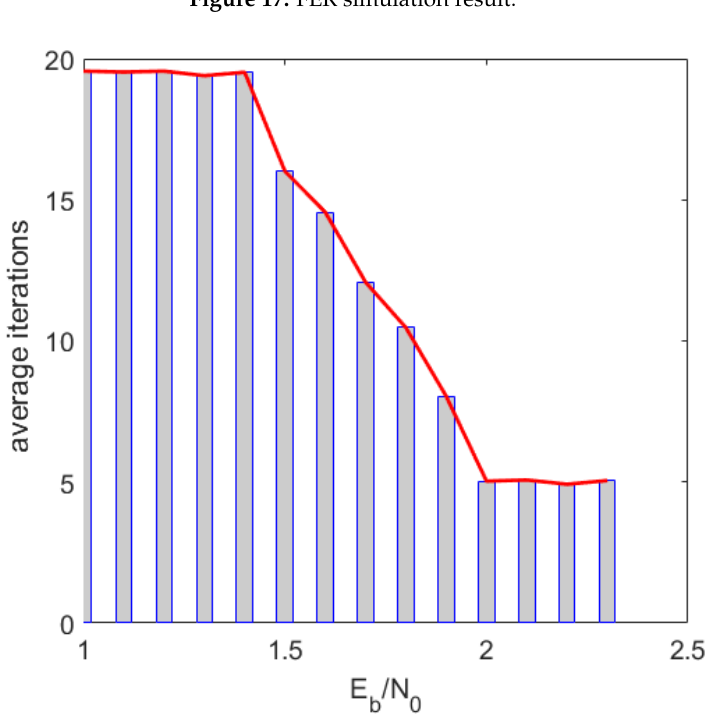
Figure 18. Average iterations simulation result at R=0.5.